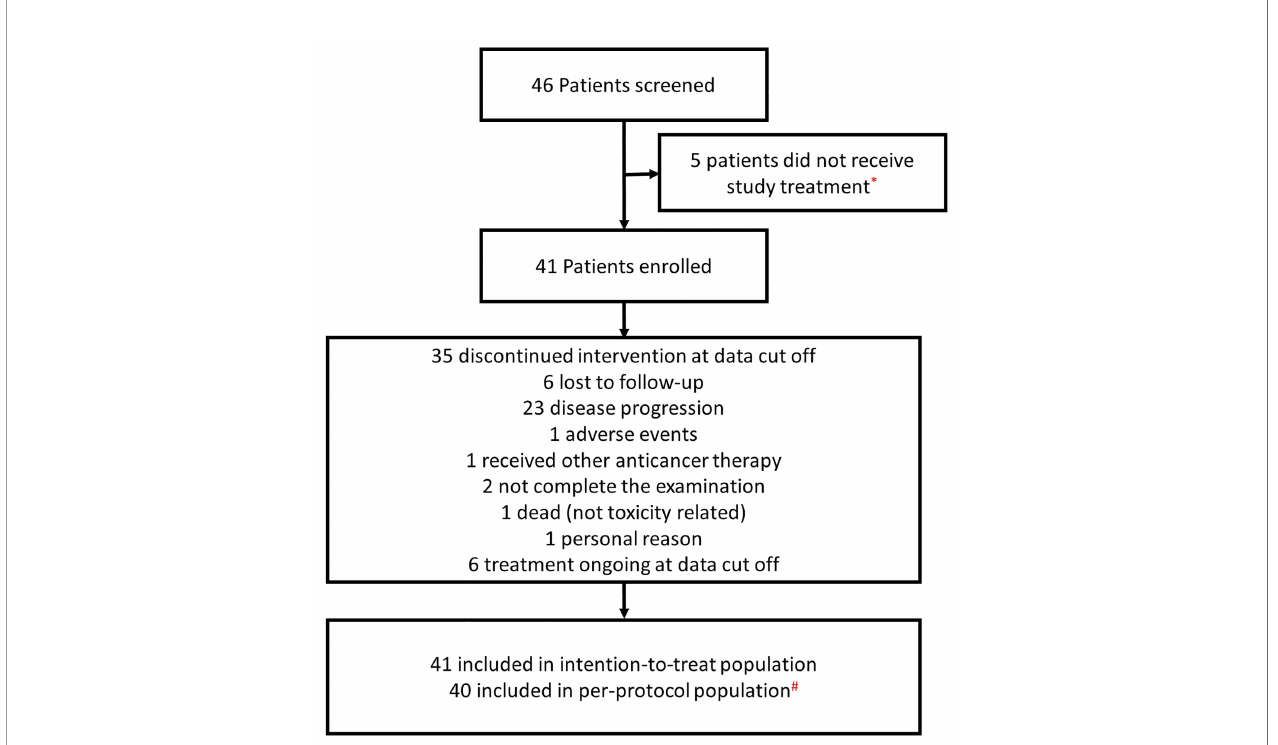
FIGURE 1 | A fl ow diagram of patients enrolled in the study. *Five patients did not initiate the study because the eligibility criteria were not met. # One patient was excluded from the per protocol population sinceno ef fi cacy assessment was performed